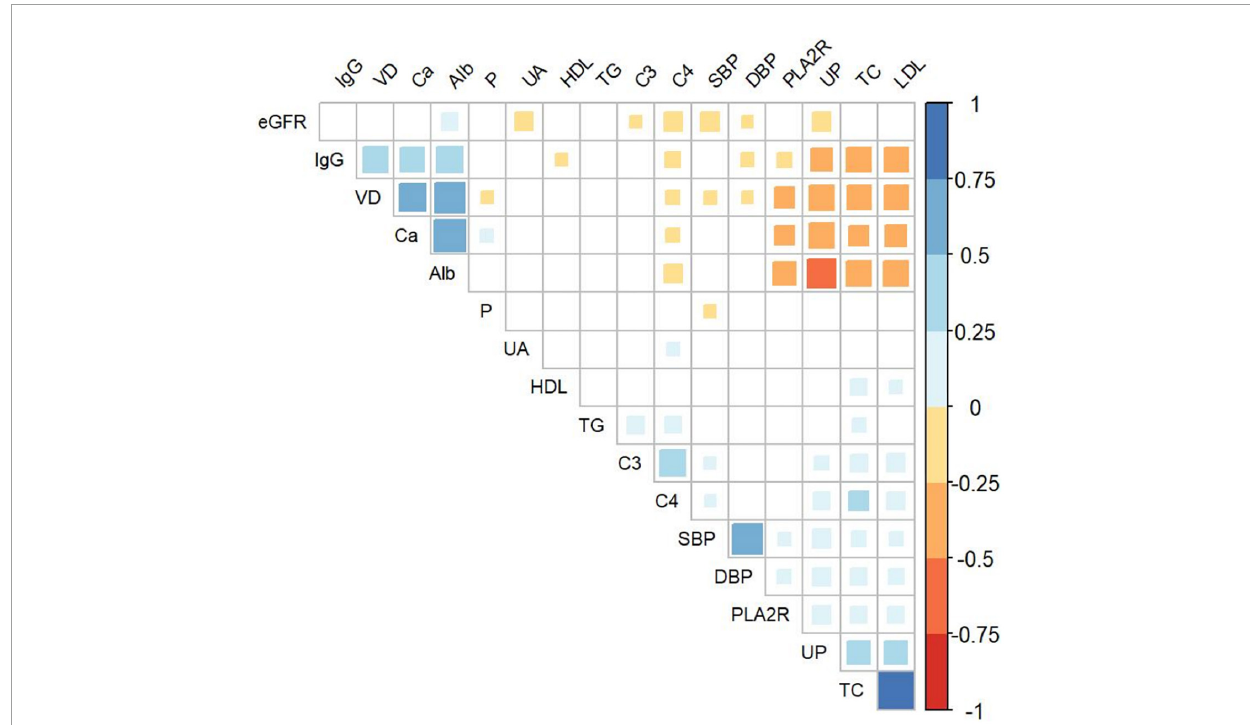
FIGURE2 Association of baseline 25(OH)D and clinical parameters in all enrolled patients. VD, serum 25-hydroxyvitamin D; IgG, serum Immunoglobulin G; Alb, serum albumin; UA, serum uric acid; TG, serum triglyceride; C3, serum complement 3; C4, serum complement 4; SBP, systolic blood pressure; DBP, diastolic blood pressure; PLA2R, seropositivity of anti-phospholipase A2 receptor antibody; UP, urinary protein; TC, serum total cholesterol; LDL, serum low-density lipoprotein cholesterol; Ca, serum calcium; P, serum phosphate; eGFR, estimated glomerular filtration